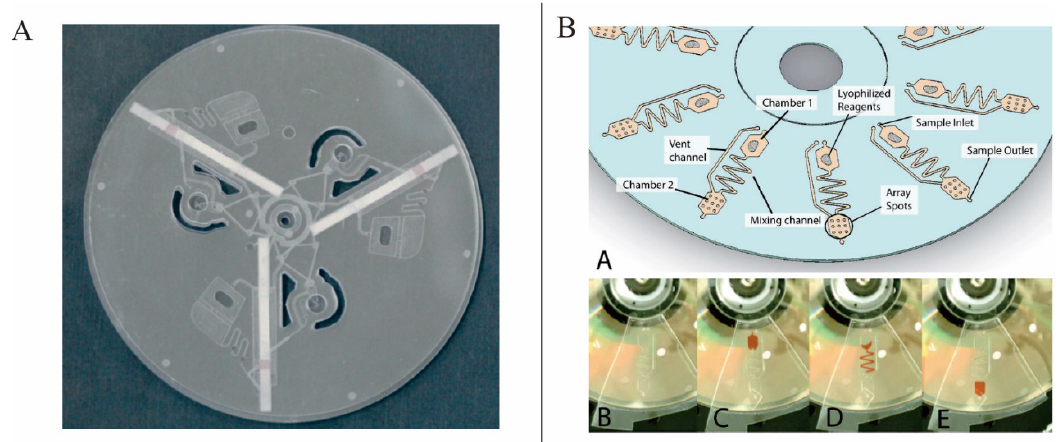
Figure 8. ( A ) RT-LAMP-ICS microdevice. Figure reprinted with permission from [91]. ( B ) Microfluidic DVDs for solid-phase RPA. Figure reprinted with permission from [96].